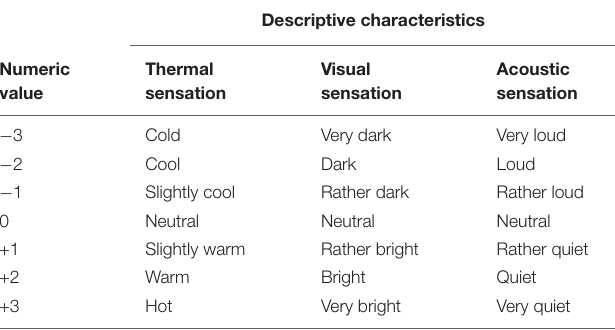
TABLE 5 | Overview of the descriptive terms used in thermal, visual, and acoustic sensation scales. Descriptive